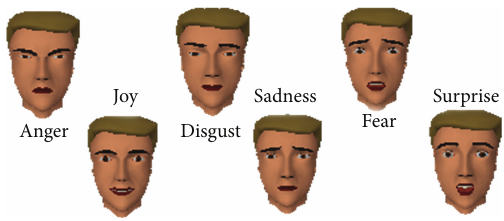
Figure 3: Six basic facial